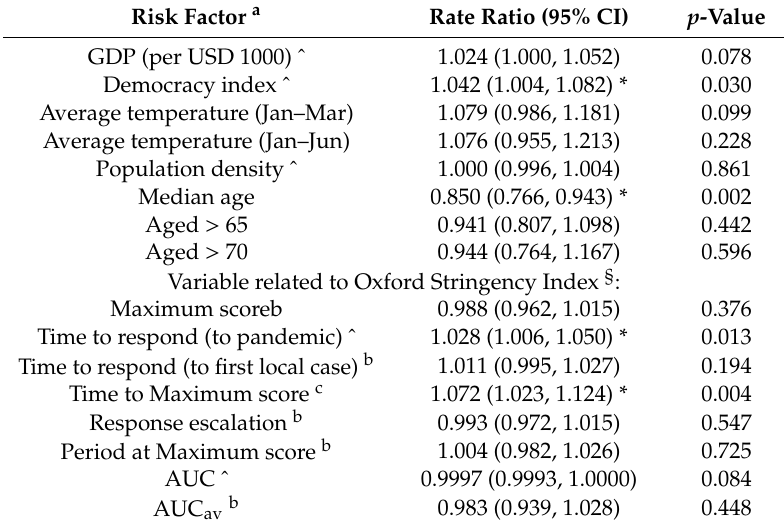
Table 3. Results of negative binomial regression models on total infections in 38 countries from 1